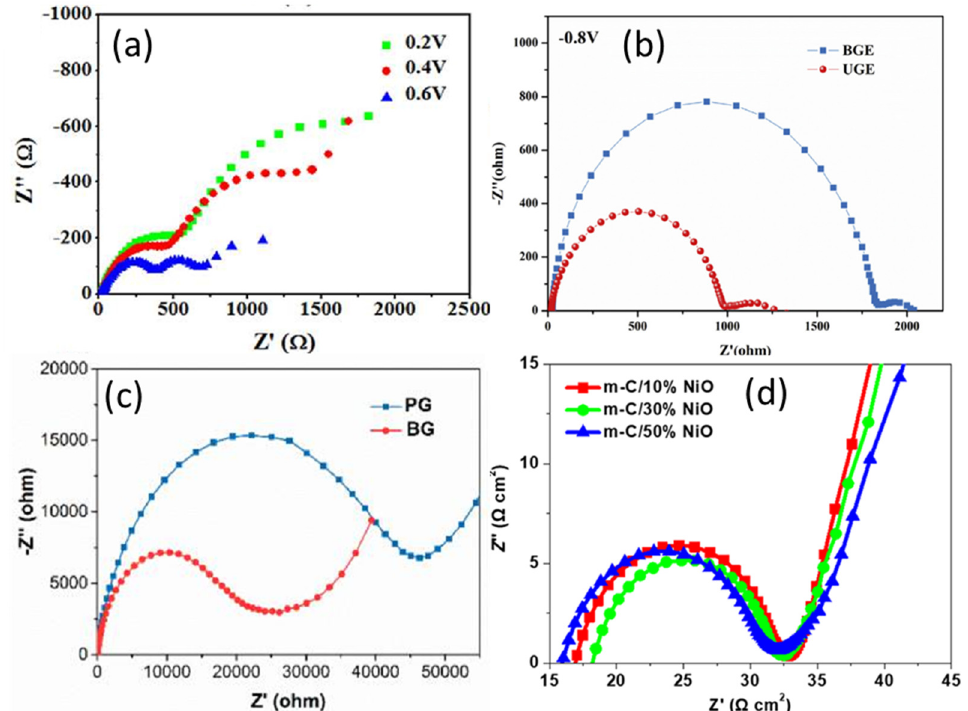
Figure 10. Nyquist plots of carbon counter electrode-based HTM-free PSCs: ( a ) graphite-based CE under different applied potentials (Reproduced with permission from [43]. Royal Society of Chemistry, 2013.); ( b ) with bulk graphite and ultrathin graphite CE, measured at 0.8 V in the dark (Reproduced with permission from [33]. Elsevier, 2017.); ( c ) with boron-free graphite and boron-doped graphite CE, measured at 0.6 V in the dark (Reproduced with permission from [34]. American Chemical Society, 2014.); and ( d ) with different amounts of NiO incorporated CE, measured at 0.5 V under illumination. Reproduced with permission from [35]. American Chemical Society, 2018.